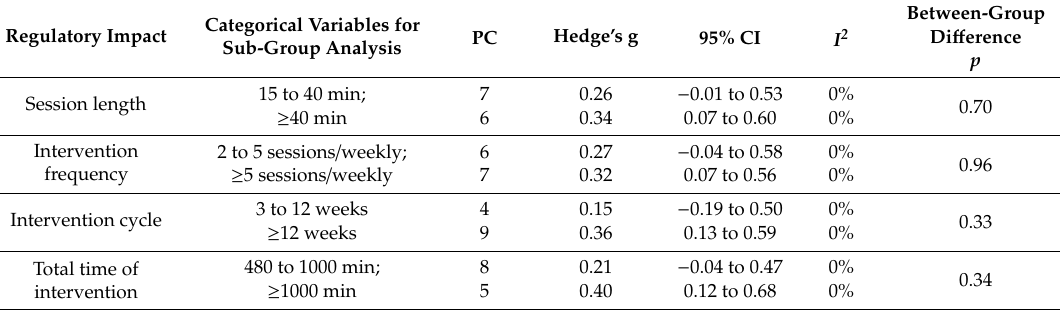
Table 3. The regulatory impact analysis of VR game groups and control